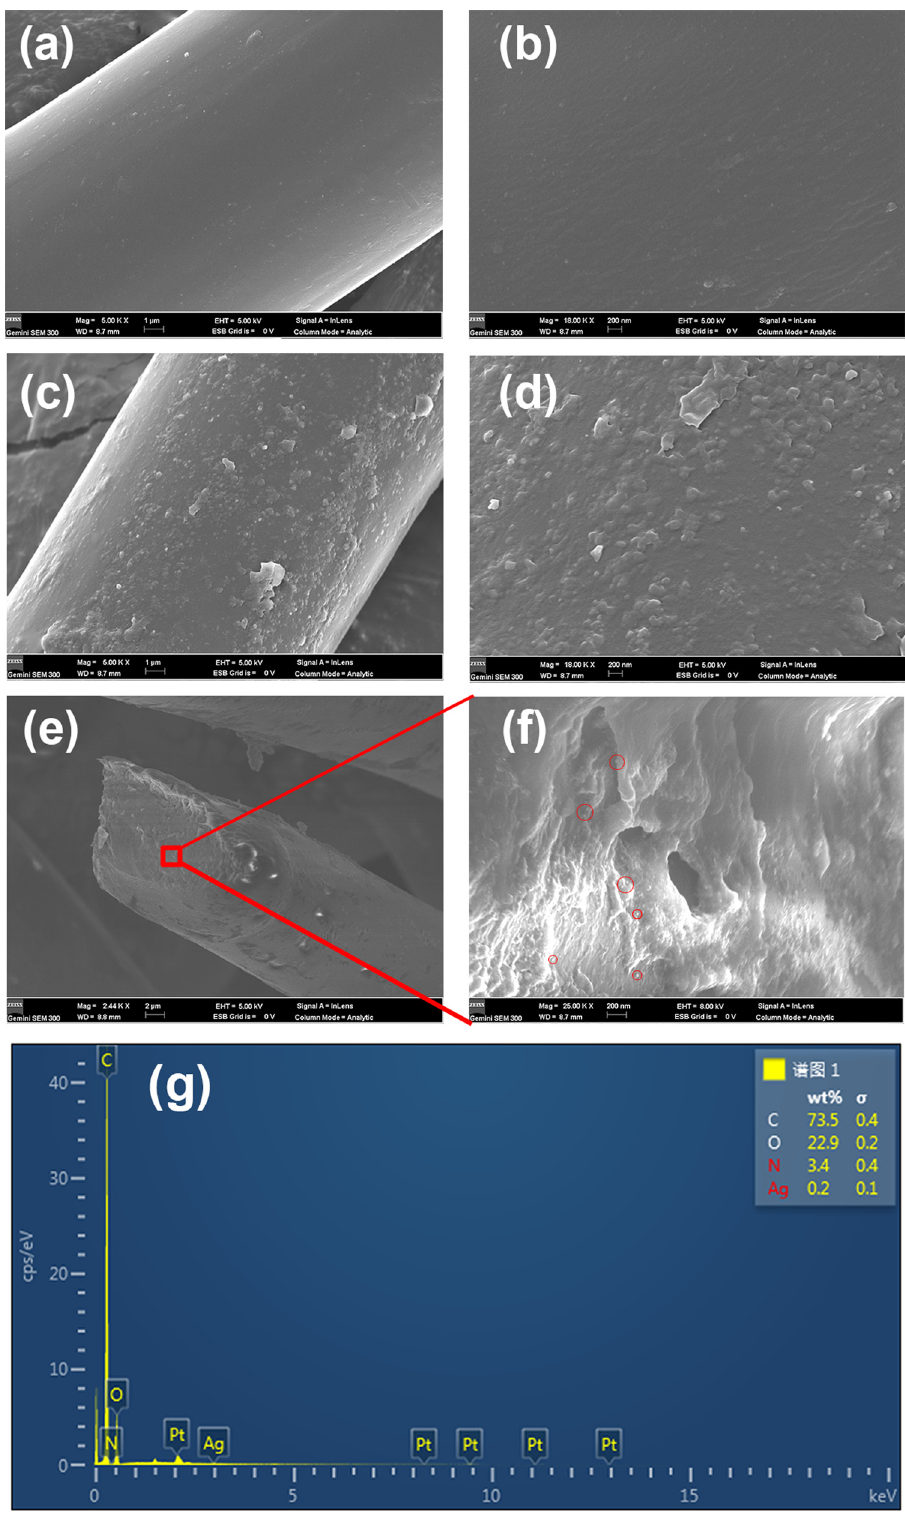
Figure 5: SEM images of ( a and b ) pure polyester fi bers, the ( c and d ) longitudinal and ( e and f ) cross sections of AgNP - coated polyester fi bers, and the ( g ) EDS spectra of coated polyester fi bers. To observe the cross - section of fi bers, polyester fi bers were combed into bundles, cut by a slicer, and pasted on the vertical sample table by the conductive